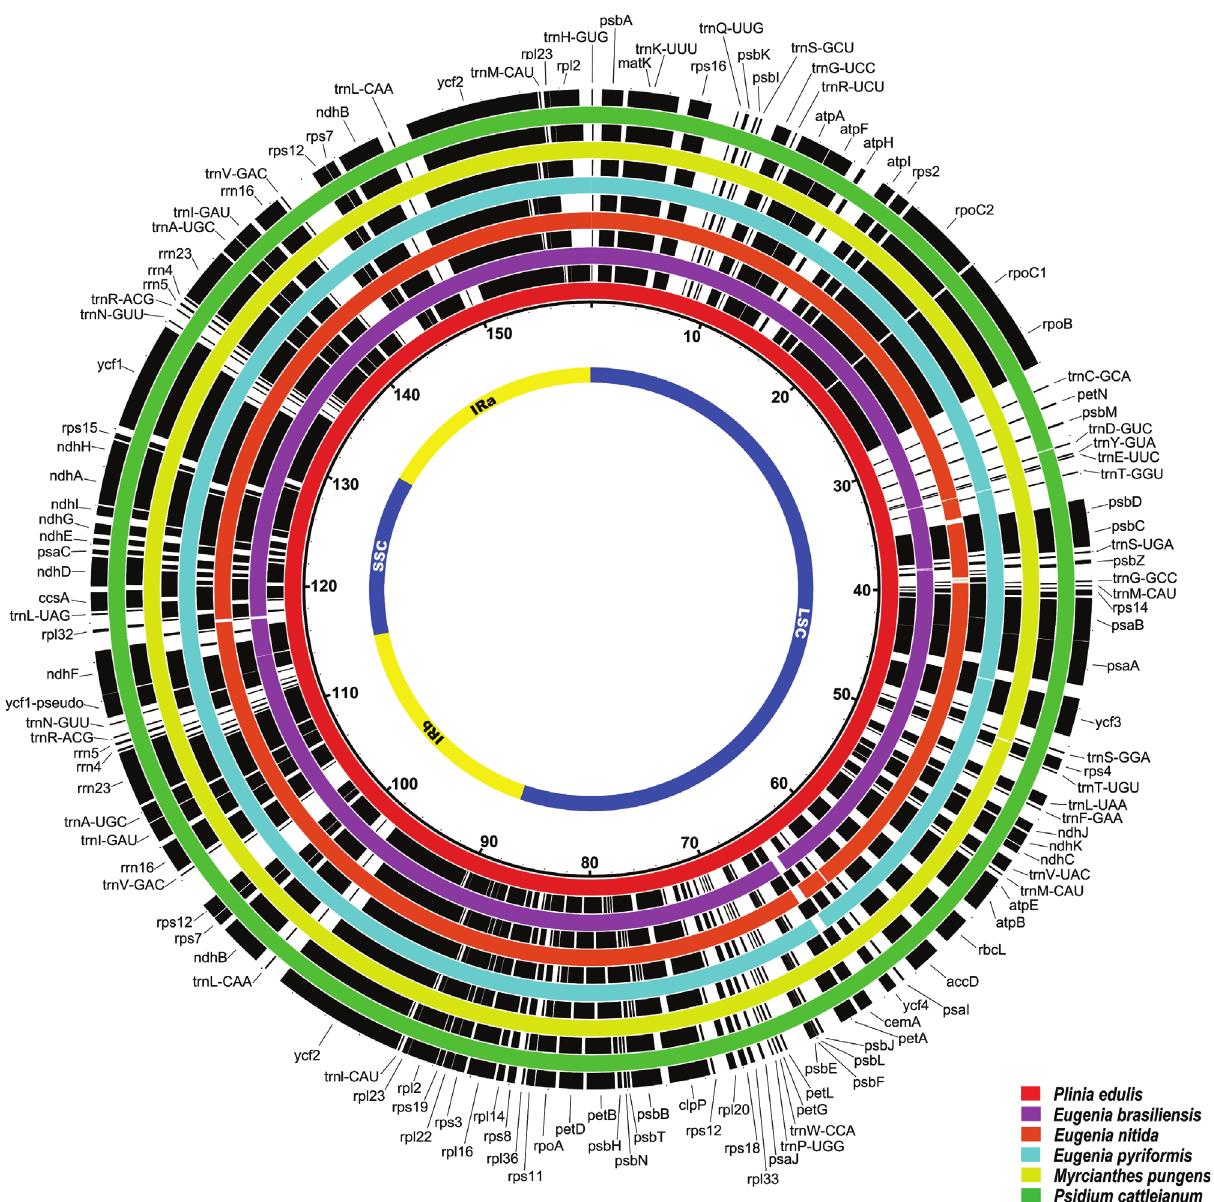
Figure 1 - Complete gene map of six Myrteae plastomes. Gene annotations are in black. The plastomes are in red ( P. edulis ), purple ( E. brasiliensis ), or- ange ( E. nitida ), blue ( E. pyriformis), yellow ( M. pungens ), green ( P. cattleianum ). LSC: large single-copy region; SSC: small single-copy region; IR: in- verted repeat. The numbers near P. edulis (red circle) represent the nucleotide positions (in